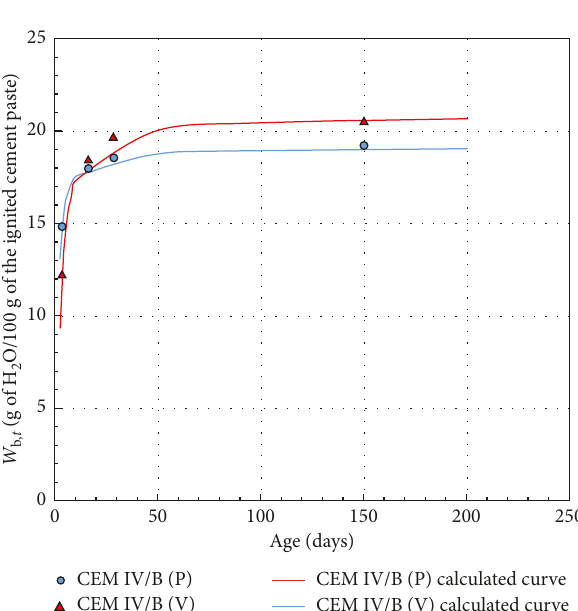
Figure 1: Hydration kinetics of the cement pastes